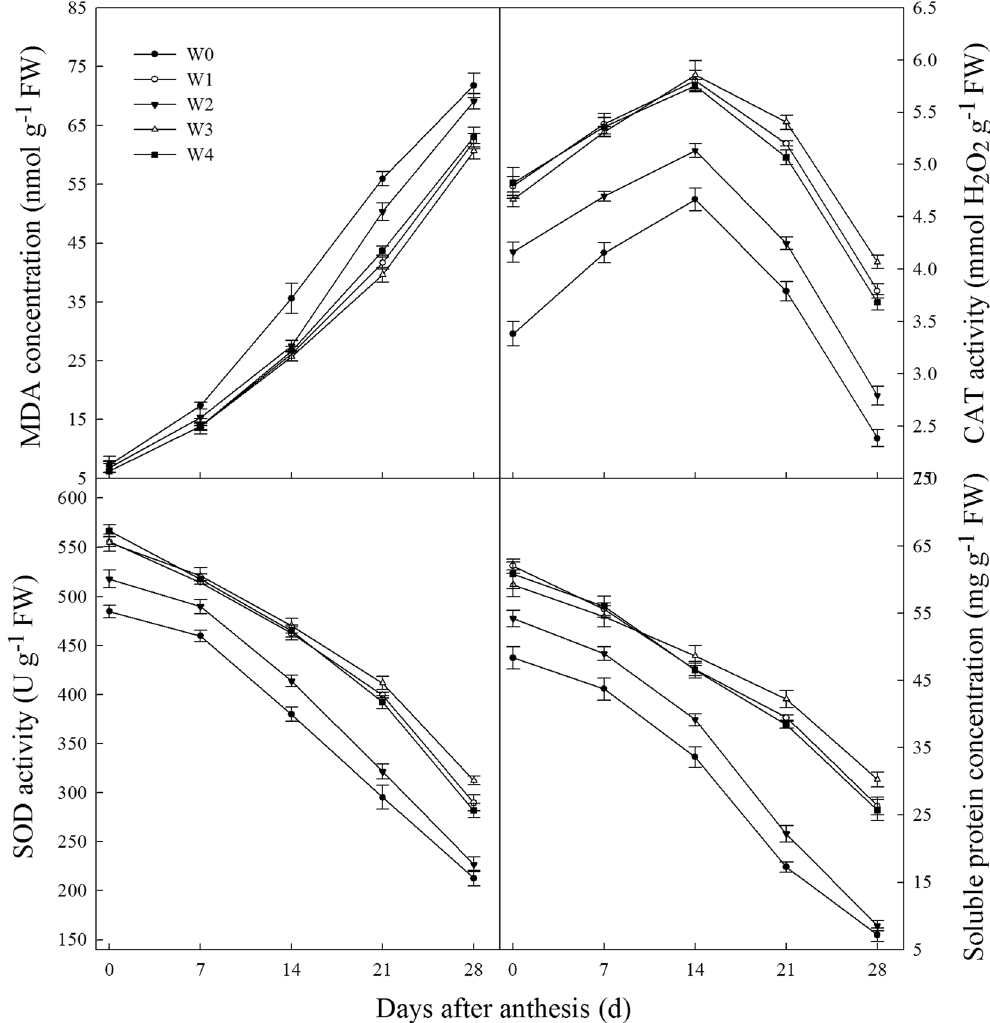
Figure 6. Changes of malondialdehyde (MDA) concentration, catalase (CAT) and superoxide dismutase (SOD) activities, and soluble protein concentration in flag leaves of wheat to different treatments in 2012/2013 growing seasons: rainfed (W0), a local supplemental irrigation practice with 60 mm of irrigation each at jointing and anthesis (W1), supplemental irrigation determined by measuring 0–20 cm (W2), 0–40 cm (W3), and 0–60 cm (W4) soil layers moisture and brought the soil moisture to 65% field capacity (FC) at jointing and 70% FC at anthesis. The vertical bars represent standard error of the mean (n =